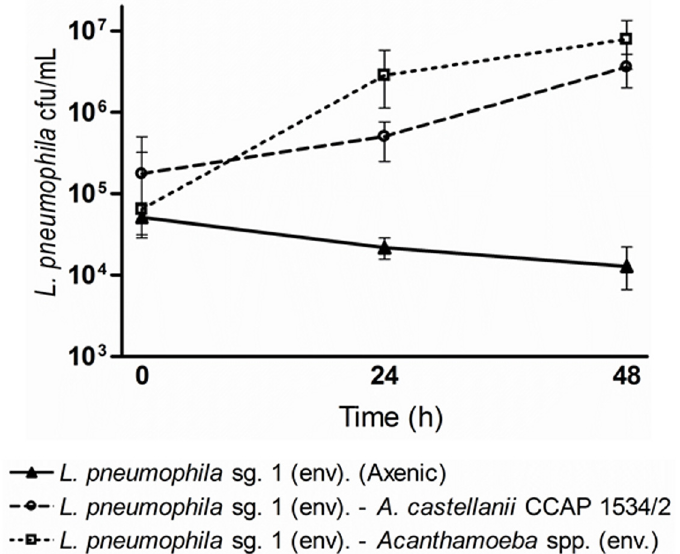
Fig 4. L . pneumophila sg. 1 growth in axenic conditions and in co-culture with the two Acanthamoeba strains in PYG liquid media. Samples were taken at different time points and plated on BCYE agar plates. Data are presented as means ± SD (error bars; n =